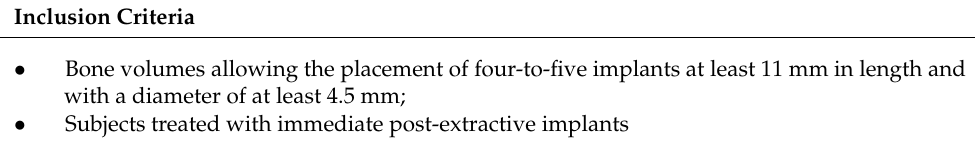
Table 1. Inclusion and exclusion